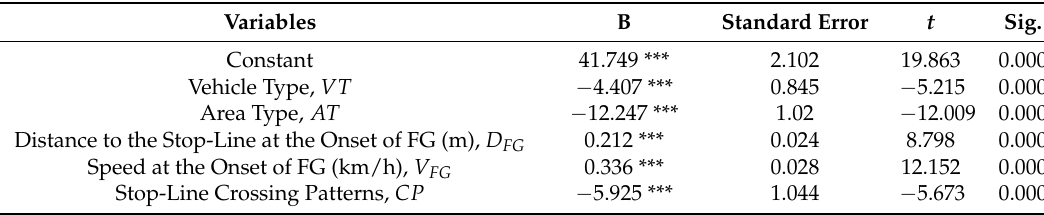
Table 4. Multiple linear regression (MLR) model estimation results for the prediction of stop-line crossing